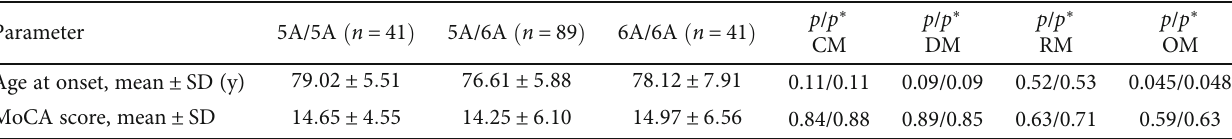
Table 5: Analysis of association between MMP3 rs3025058 (-1171 5A/6A) genotypes and clinical fi